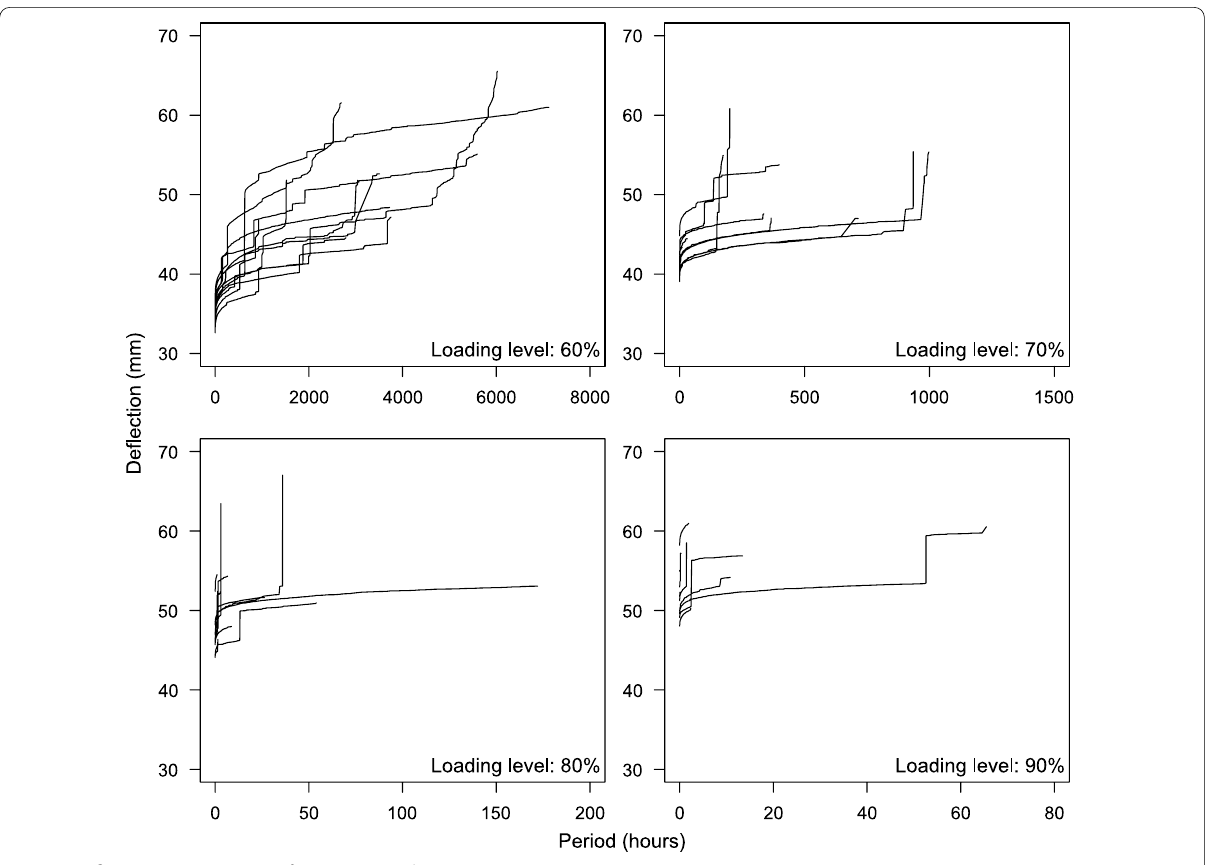
Fig. 9 Deflection at span center of specimens with